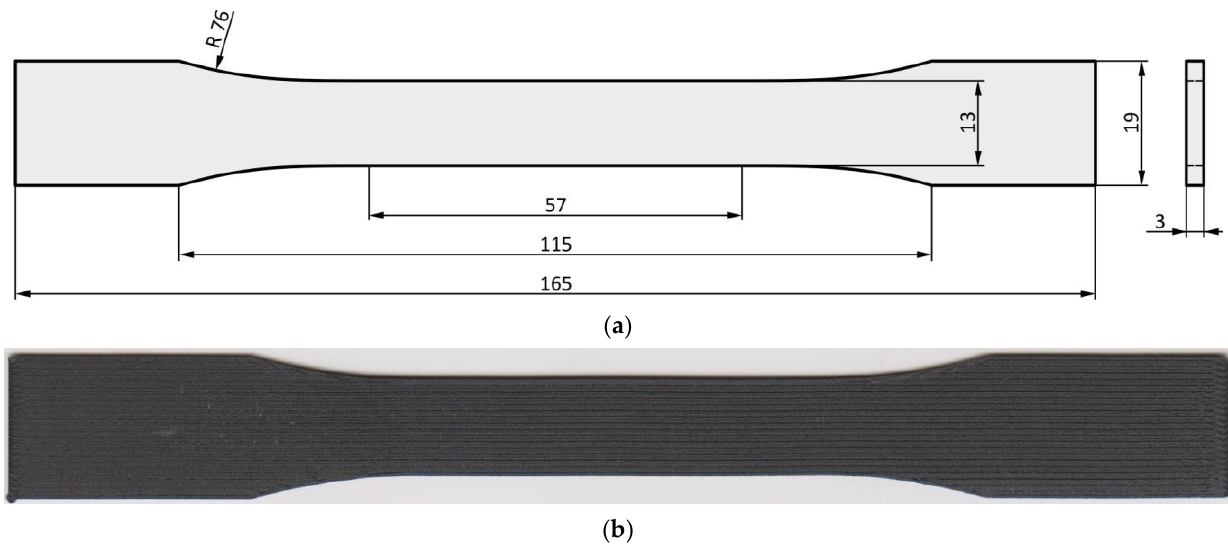
Figure 3. Specimen shape: ( a ) dimensioned drawing according to ASTM D638-14; ( b ) photo of a printed specimen.